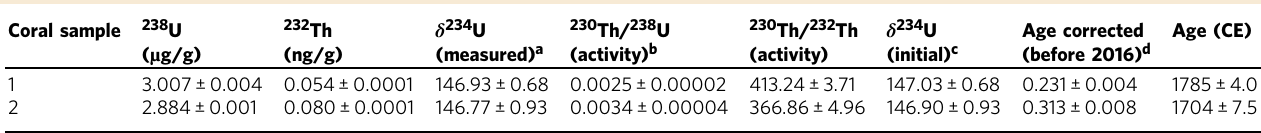
Coral sample 238 U